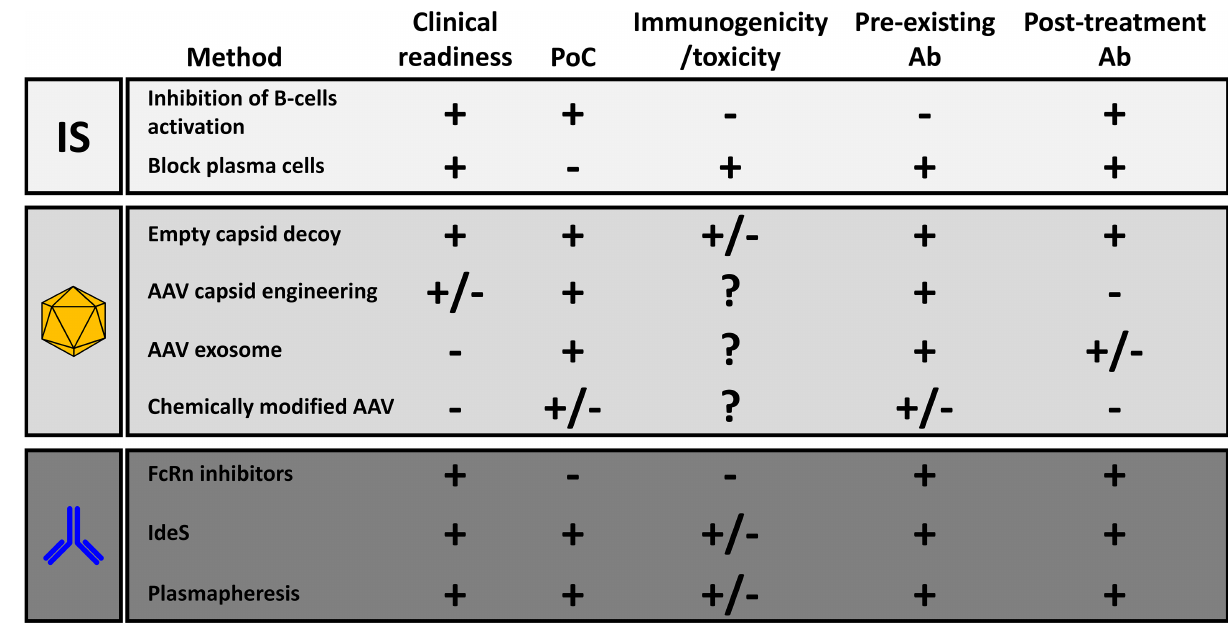
FIGURE 2 | Comparative analysis of the different methodsto reduce the anti-AAV humoral response. The last two columns refer respectively to the ef fi cacy of the method in the reduction of the impact ofpre-existing neutralizing antibodies orin the inhibition of the anti-AAVhumoral immunity after treatment with recombinant vectors. PoC, proof- of-conceptwith AAV vector gene transfer;Ab, antibodies; FcRn,neonatal Fc-receptors; IdeS, Immunoglobulin G-degradingenzyme of S.